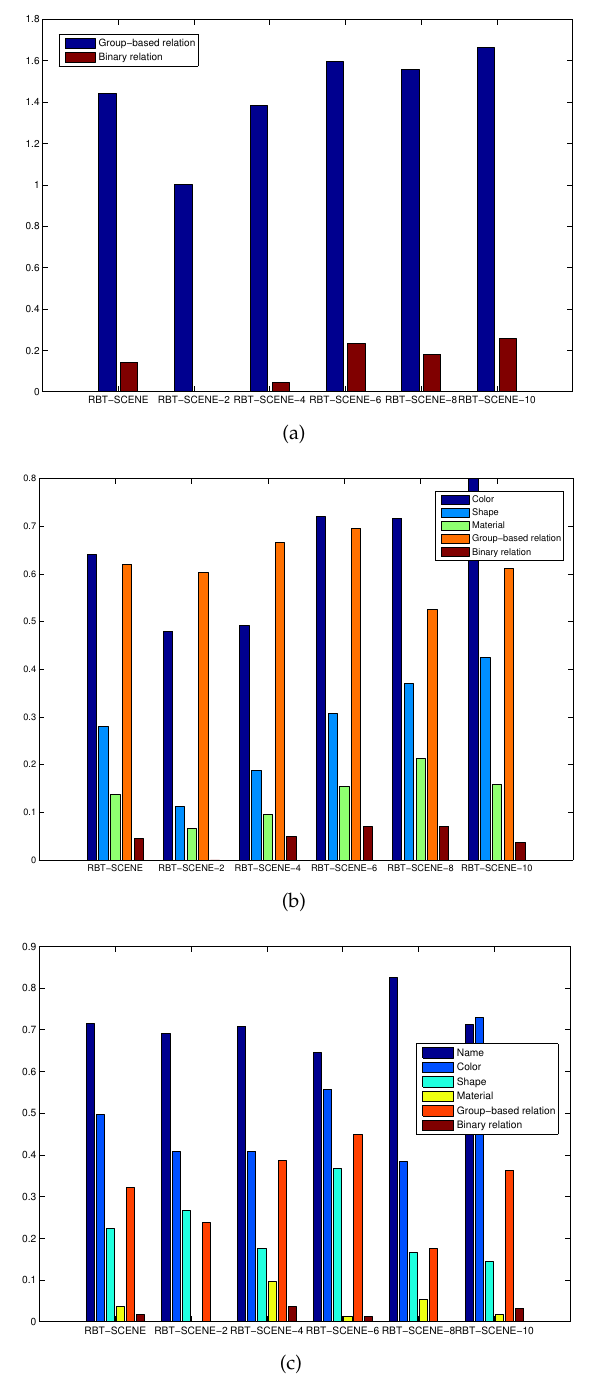
Figure 8. Occurrence frequency of different attributes and relation labels used by people for target object specification in NL-INST-1 ( a ), NL-INST-2 ( b ) and NL-INST-3 ( c ) corresponding to different subsets of the RBT-SCENE